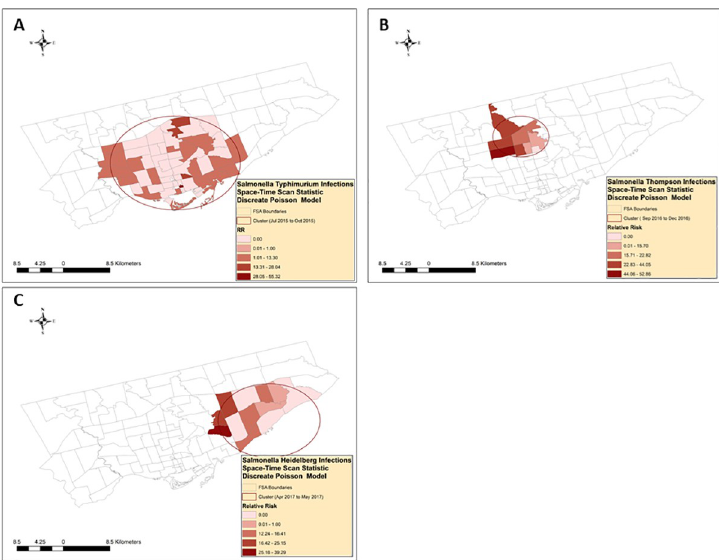
Fig 6. Space-time clusters of nontyphoidal Salmonella enterica infections with serotypes (A)Typhimurium, (B) Thompson, and (C) Heidelberg, identified by the scan statistic 1. 1 Retrospective space-time analysis, scanning for clusters with high rates, using discrete Poisson